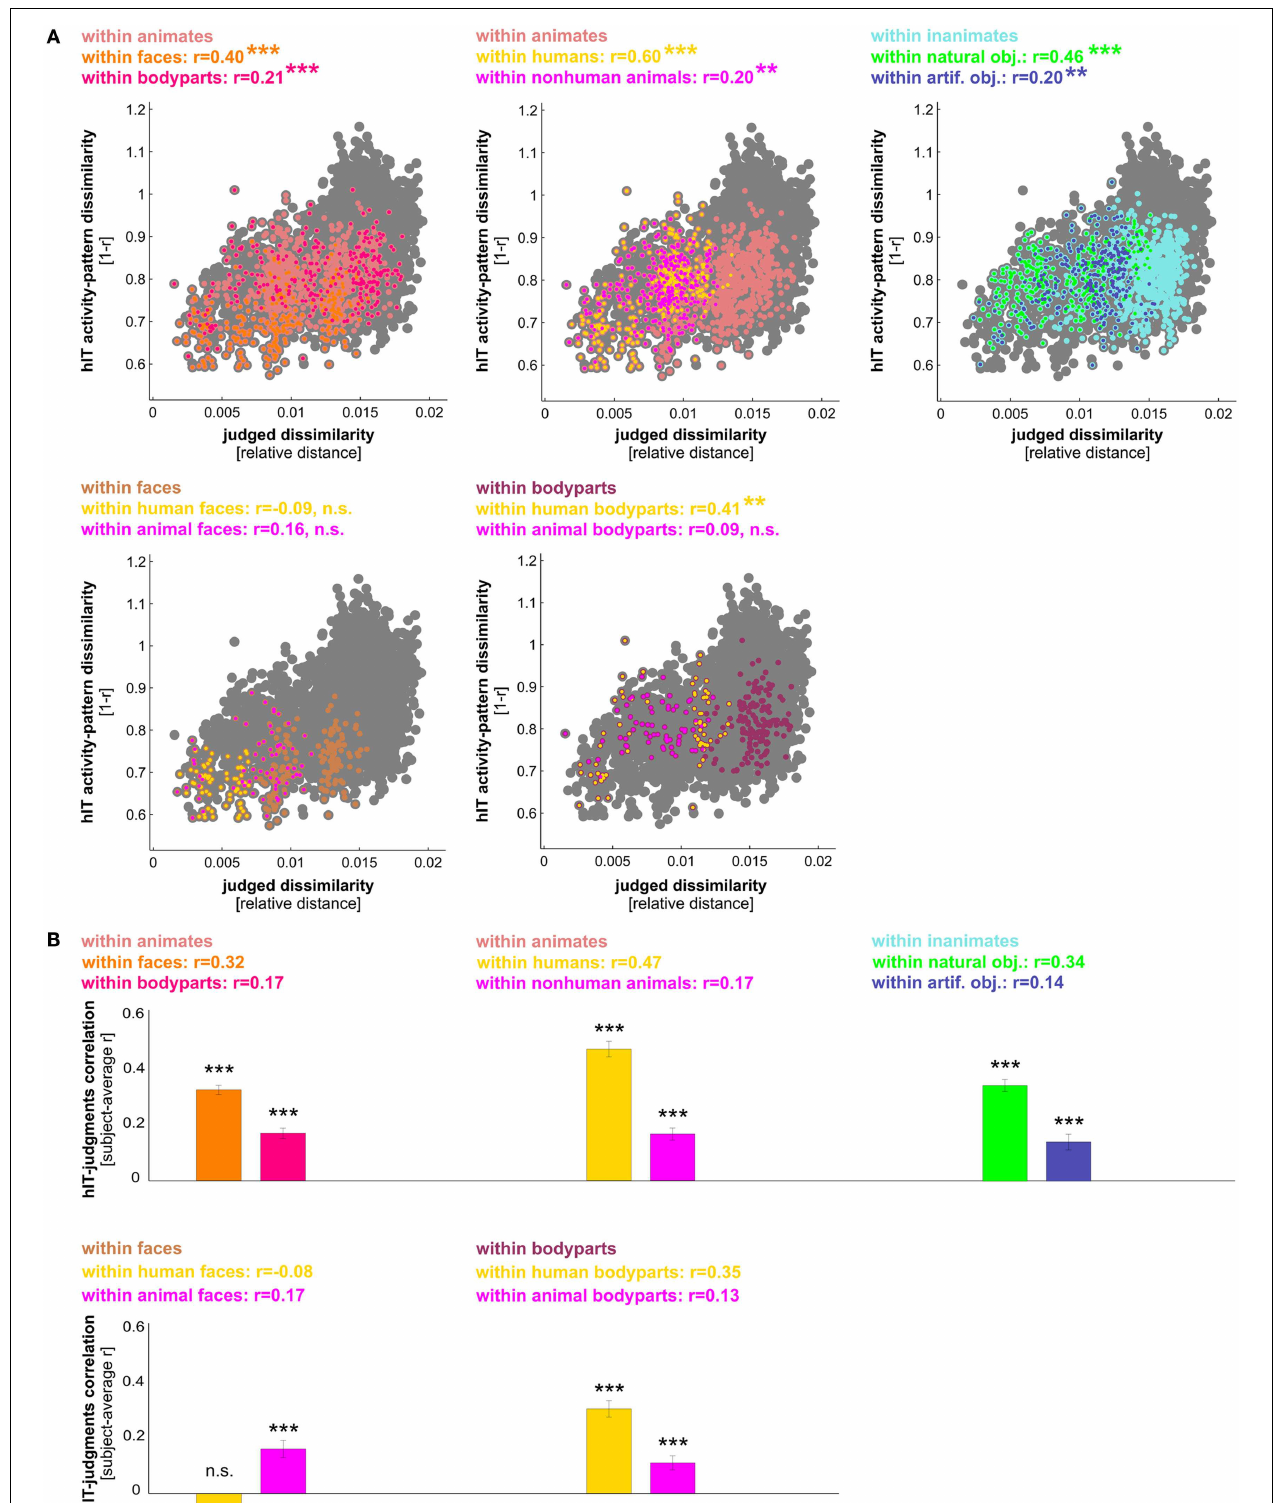
subject-average RDMs in Figure 3A . A dot is placed for each stimulus pair based on its hIT activity-pattern dissimilarity and judged dissimilarity.The large